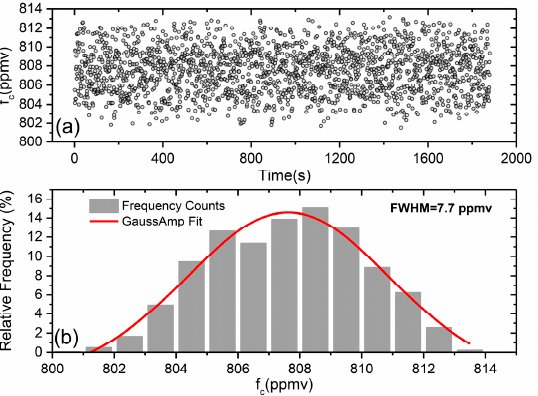
Figure 4. Results of time-series continuous measurement. ( a ) Continuous measurement of a mix- ture of 810.6 ppmv CO 2 sealed in the MPGC, a total of 1880 data points acquired with 1 s interval. ( b ) Histogram plot and Gaussian profile, to assess the precision of the system.